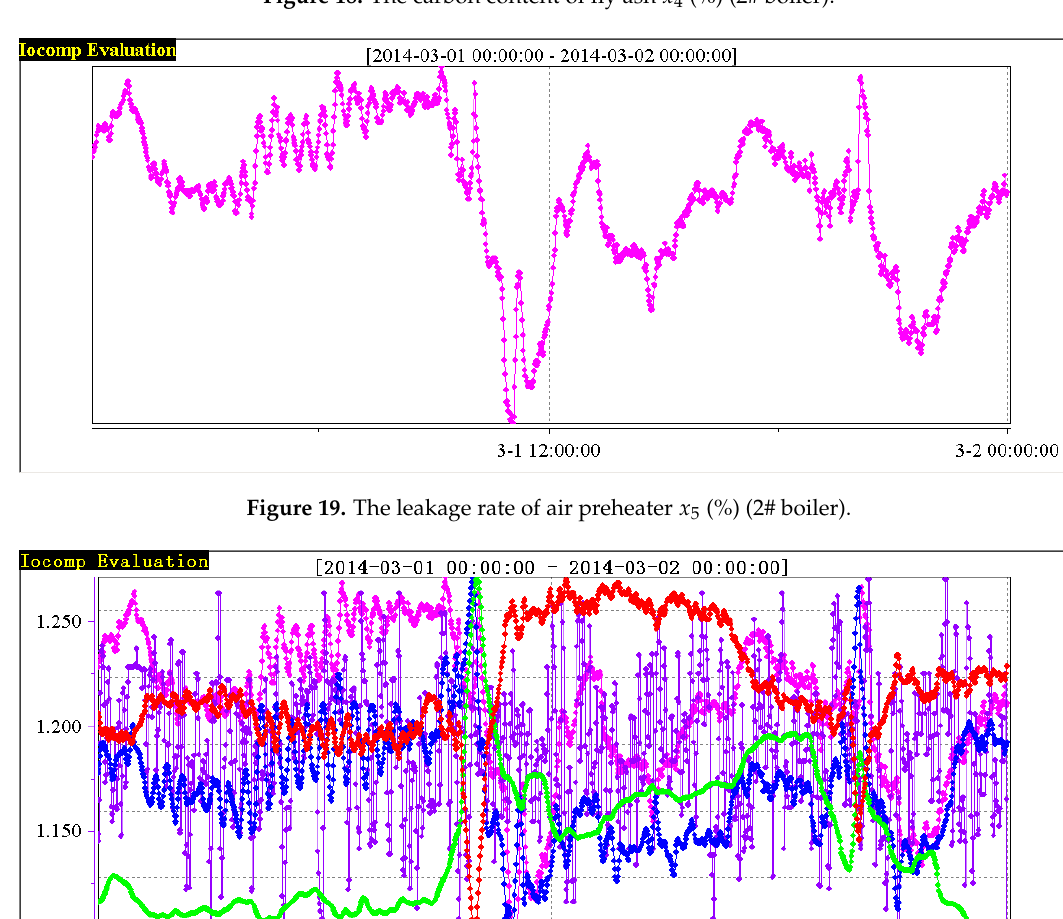
Figure 20. Five variables x 1 , x 2 , x 3 , x 4 and x 5 (2#